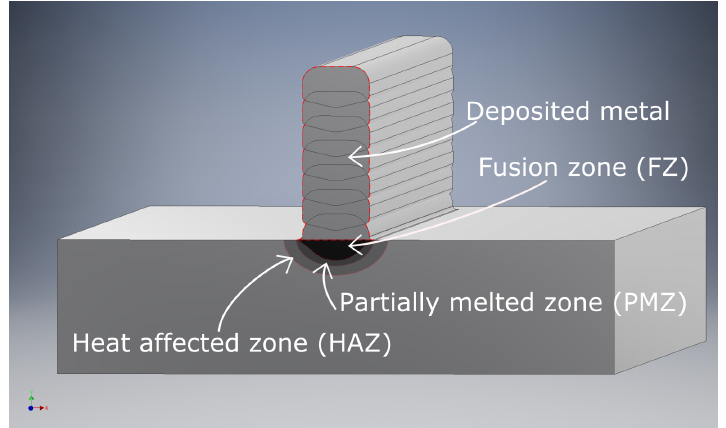
Figure 1. Areas of interest of the ISDM on a cross section perpendicular to the deposition